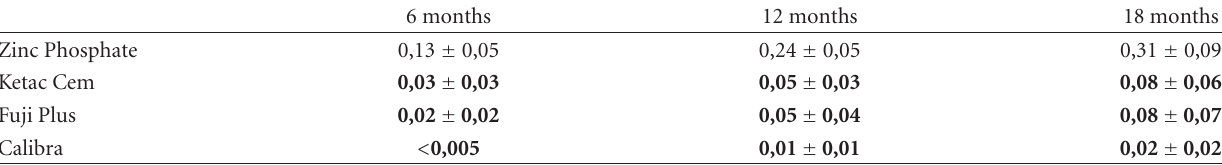
Table 3: Mean volume loss (mm 3 ) observed for the tested cements as a function of